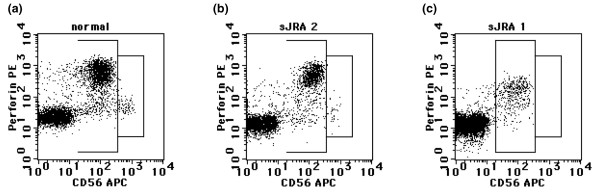
Flow cytometric analysis of CD56bright and CD56dim natural killer cells. (a) In healthy individuals, most circulating NK cells are CD56dim (about 90%) and express high levels of perforin. In contrast, CD56bright NK cells comprise about 10% of all human NK cells and express low levels of perforin. (b, c) Two distinct patterns of CD56 staining observed in patients with systemic juvenile rheumatoid arthritis (sJRA): (b) normal pattern (observed in 17 of 20 patients with sJRA as well as in all controls, and all other JRA patients); (c) almost complete disappearance of CD56bright subset of NK cells (observed in 3 of 20 patients with sJRA only).